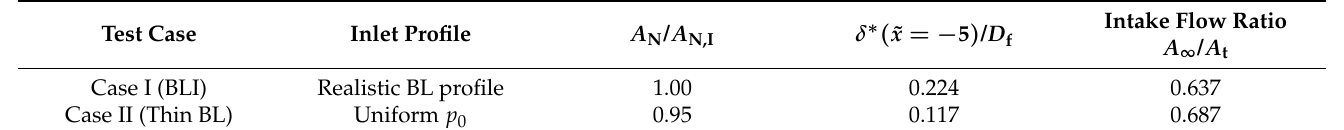
Table 2. Test case parameters. δ ∗ is the BL displacement thickness.